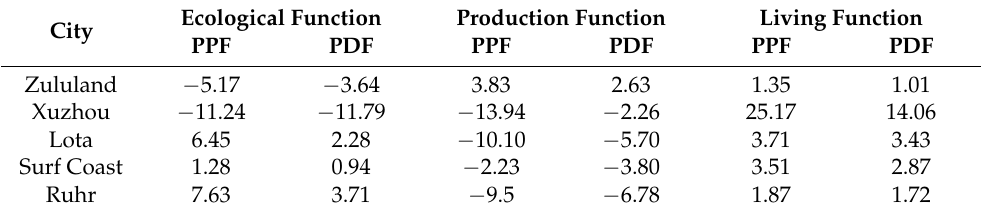
Table 3. Variation of PPF and PDF of five cities from 1975 to 2020. Unit: Percentage. Ecological Function Production Function City